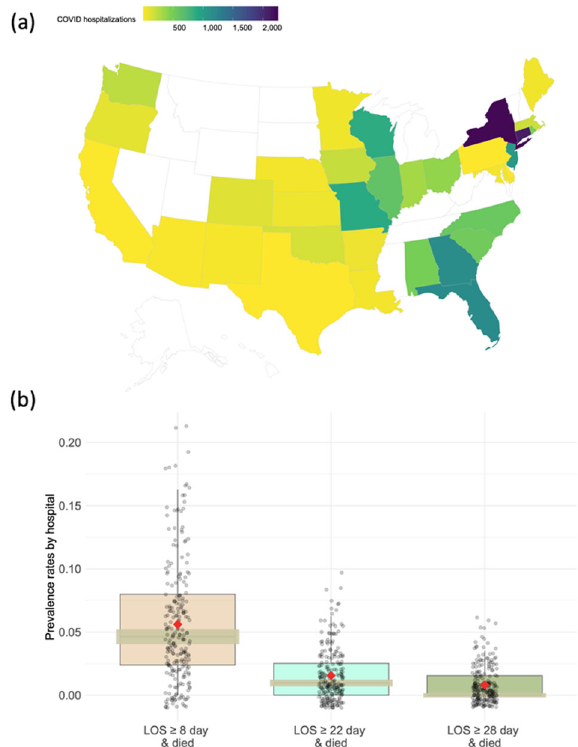
Fig. 1 Summary of real-world data from 230 sites. a COVID-19 cases distribution: number of COVID-19 hospitalizations included in the study are represented across 47 states created by open-source R package usmap 34 (https://cran.r-project.org/web/packages/usmap/ usmap.pdf) ( b ) Box plots of the prevalence rates of composite outcomes of 230